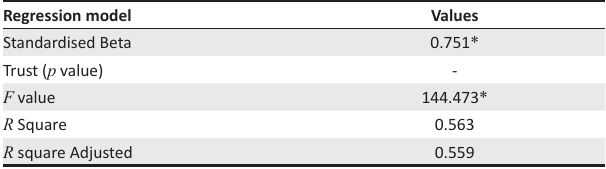
TABLE 6: Regression